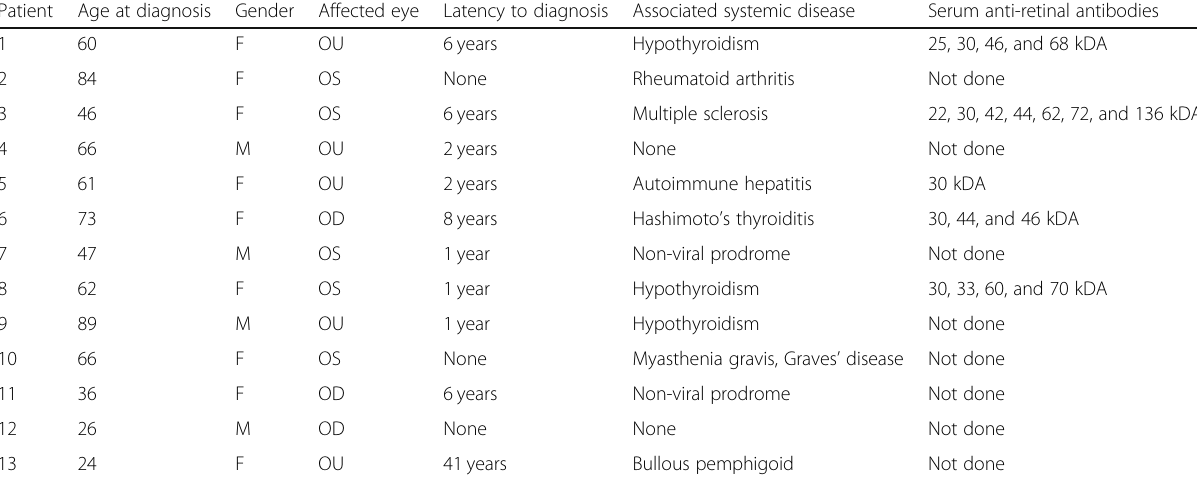
Table 1 Clinical and demographic information on all 13 patients with npAIR Patient Age at diagnosis Gender Affected eye Latency to diagnosis Associated systemic